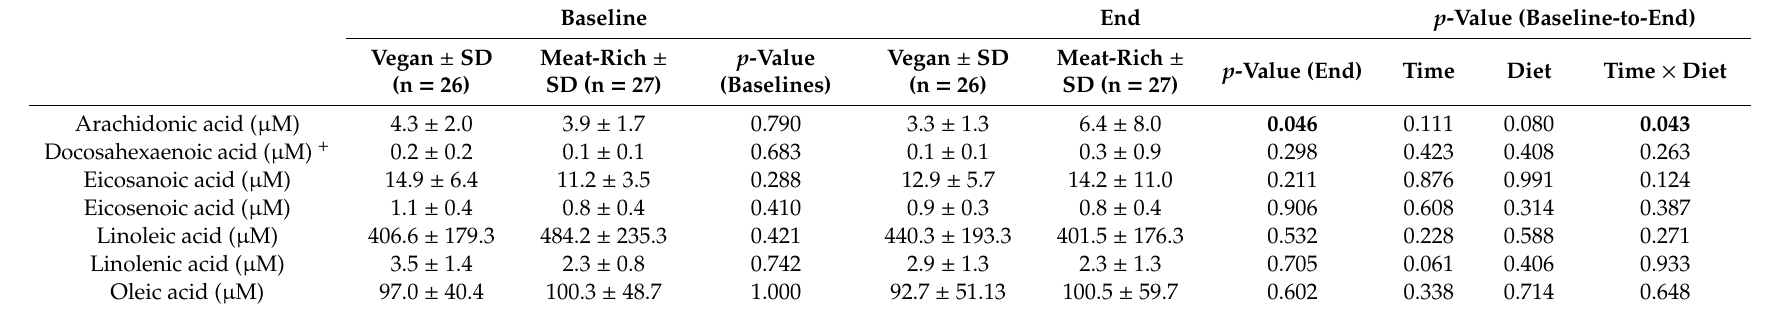
Table 6. Concentration of fatty acids measured in blood serum between vegan group and meat-rich group before and after four weeks of intervention + It was only possible to measure this in 14 VD subjects and 23 MD subjects; VD = Vegan diet; MD = Meat-rich diet; SD = Standard deviation; p -value (baselines) indicates comparison of values at baseline (results from t -test or MWU-test). p -value (end) indicates comparisons at the end of the study adjusted for baseline values (results from ANCOVA). p -value (baseline-to-end) indicates comparisons of changes from baseline to end of study (results from mixed ANOVA). Statistically significant results are bolded ( p <